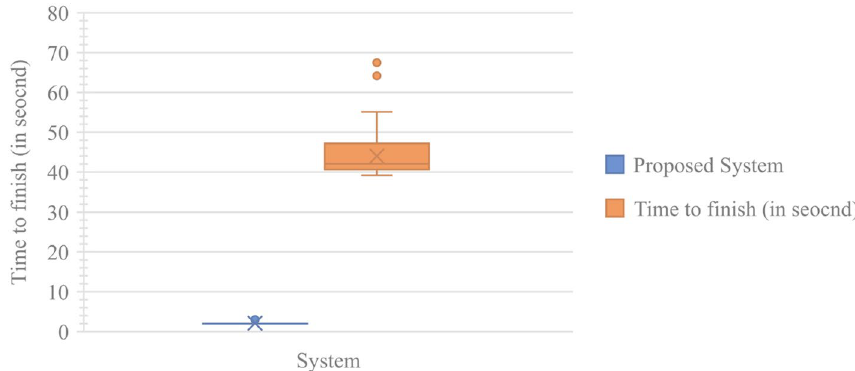
Fig. 9 Box plot chart for database write evaluation